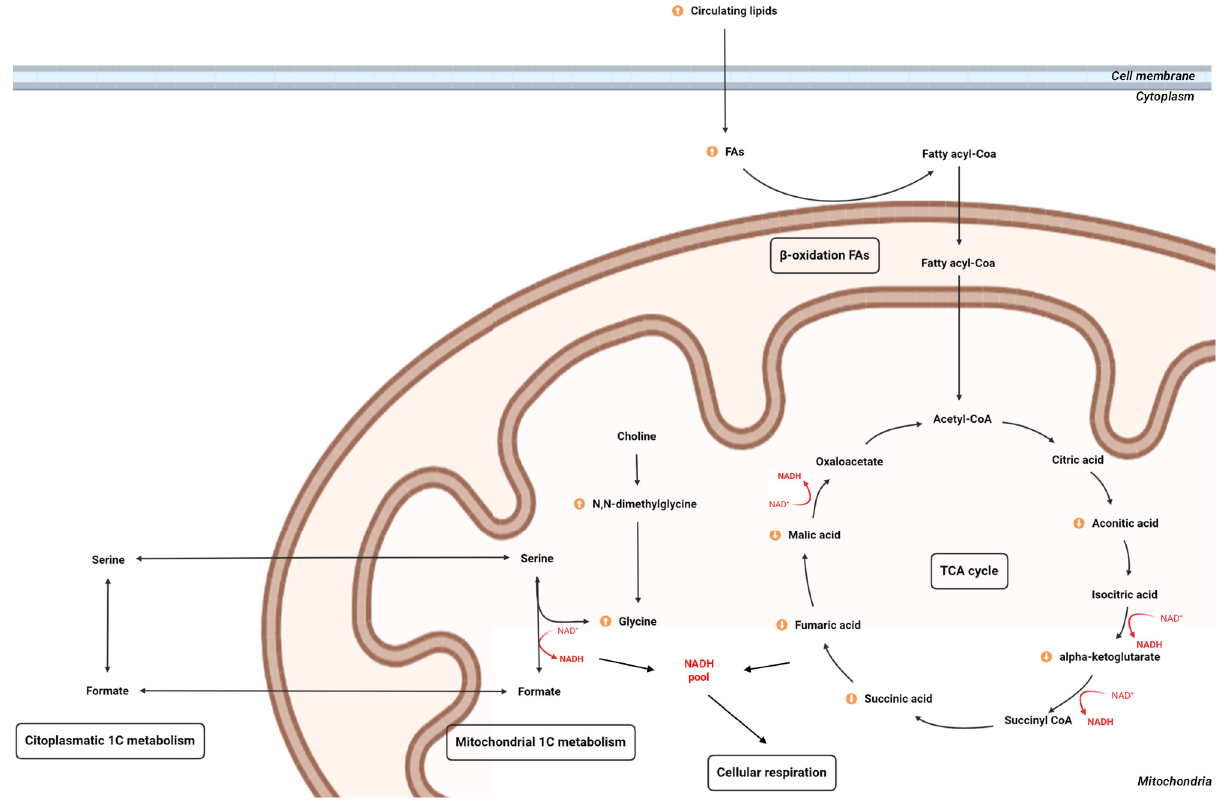
Figure 6. A schematic overview of the metabolic pathways involved in the LPS-induced inflammation model. In the context of mitochondria, TCA cycle is the nexus between FAs through β -oxidation disruption, glycine through 1C metabolism and cellular respiration. Abbreviations: FA, fatty acid; NAD+/NADH, nicotinamide adenine dinucleotide oxidized and reduced.